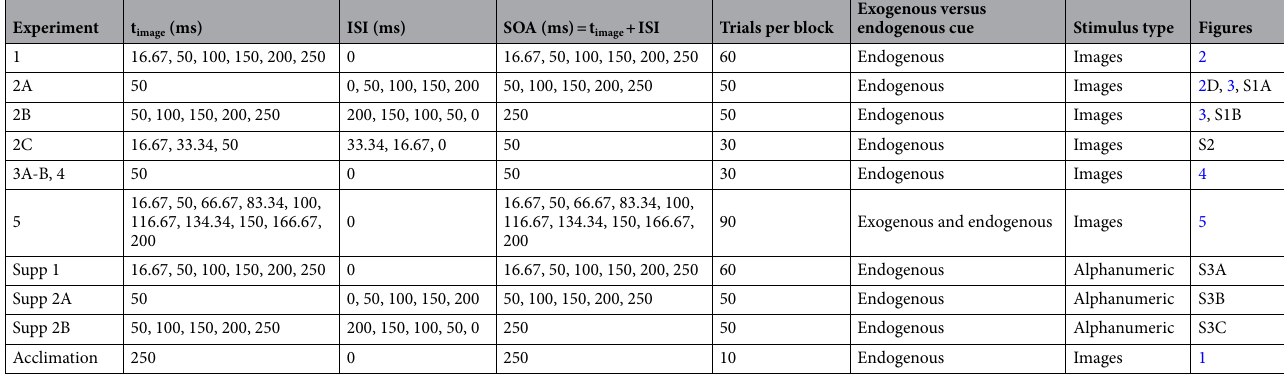
Table 1. SOA, filler, and presentation feature details for main and supplemental